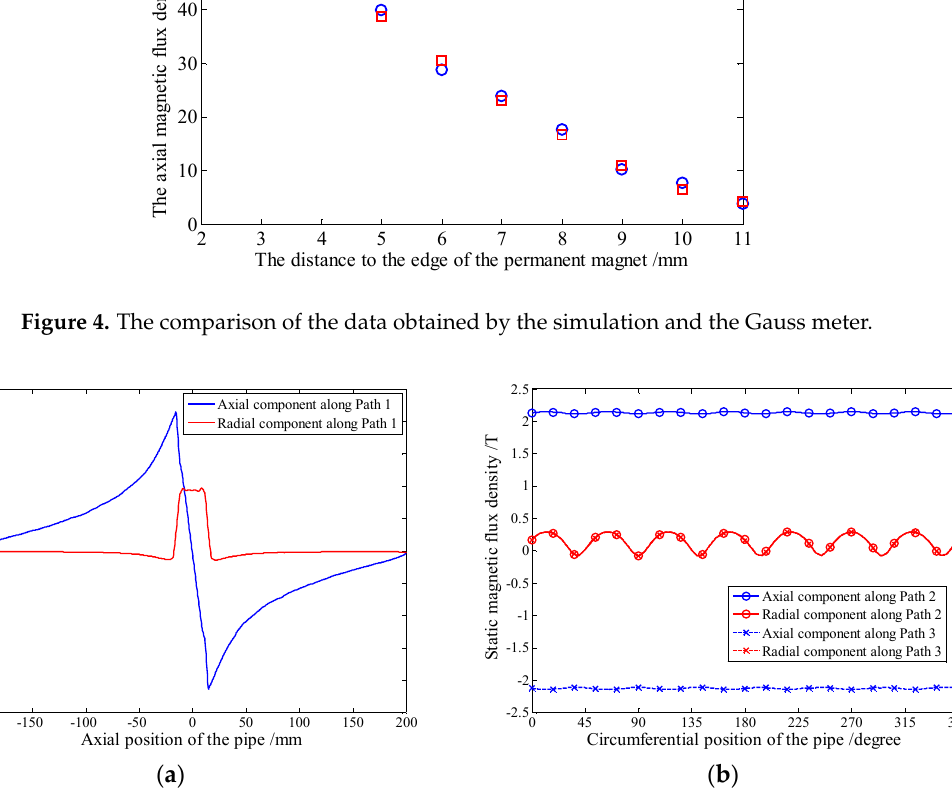
Figure 5. The static magnetic field distributions at 1 mm depth beneath the outer surface of the pipe along different paths ( a ) Path 1 ( b ) Path 2 and Path 3.